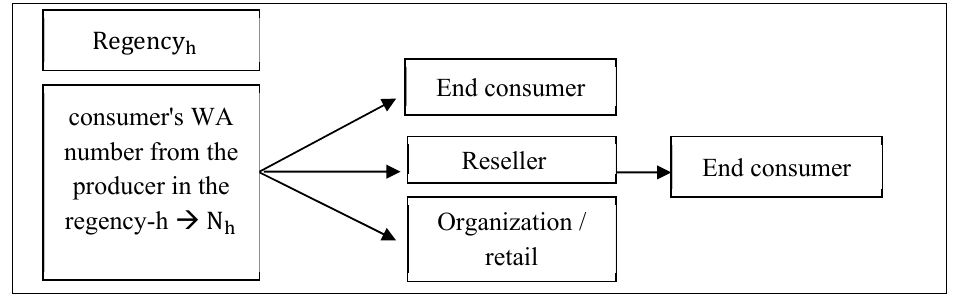
Fig. 3. Determination of the Initial Population of End Consumers